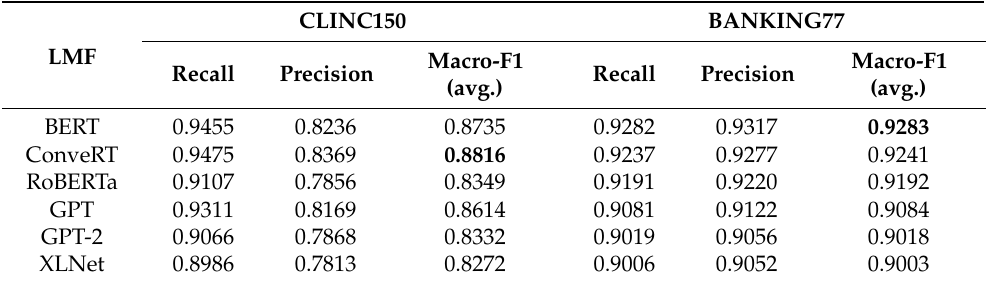
Table 3. Recall, precision, and F1 classification scores obtained using different types of language model featurizers (LMF). Best performing models, in terms of macro-F1 average score, have their results in bold.